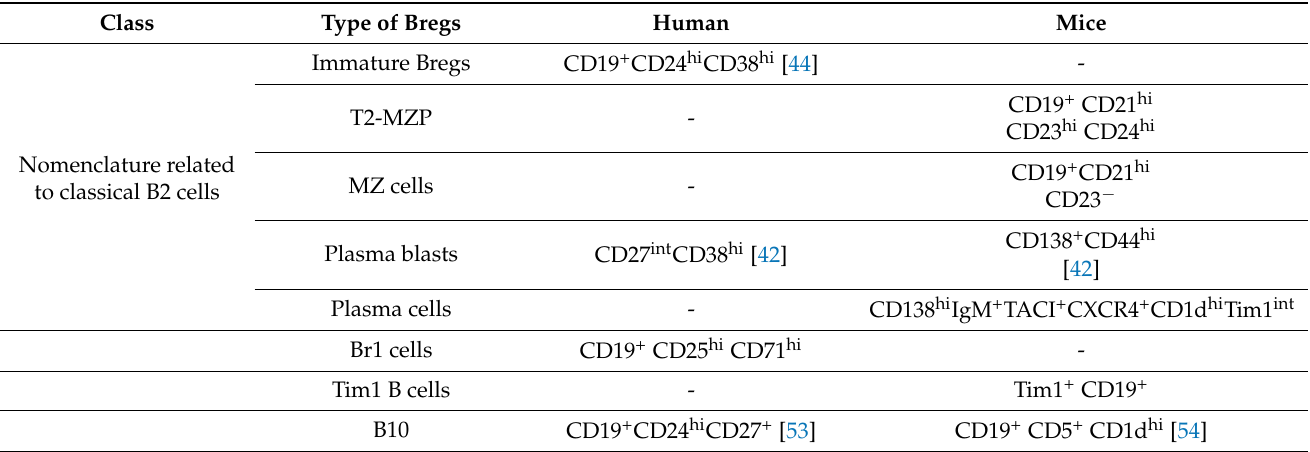
Table 2. Mouse versus human